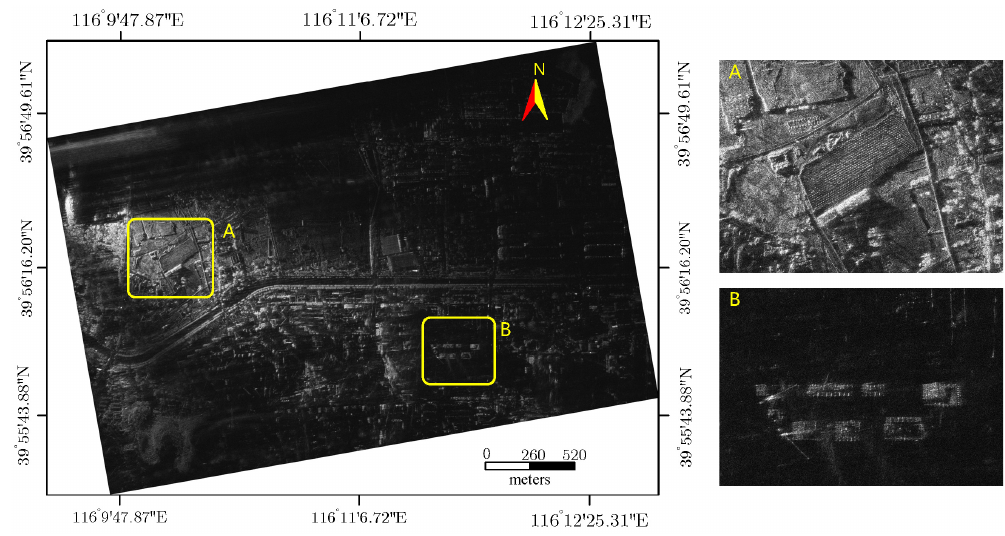
Figure 15. The SS-BiSAR image processed by the proposed algorithm. Area A and B are used for demonstrating the focusing performance. Area A contains an athletic field and some trees. Area B contains some